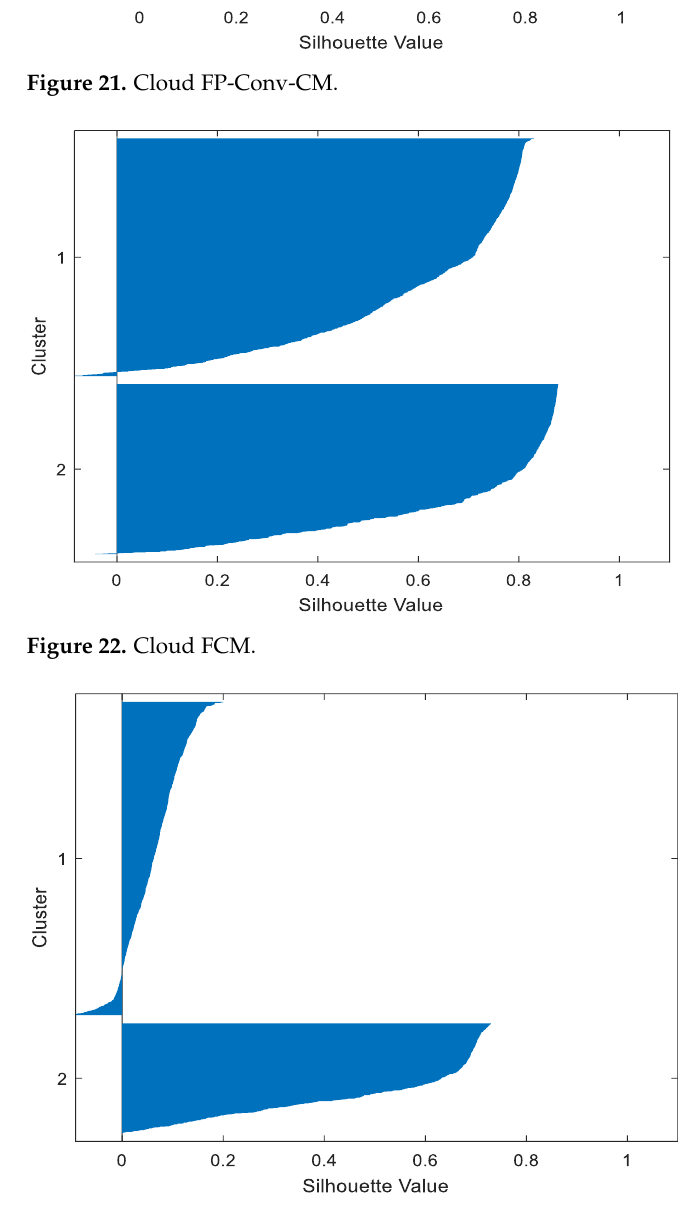
Figure 23. Cloud